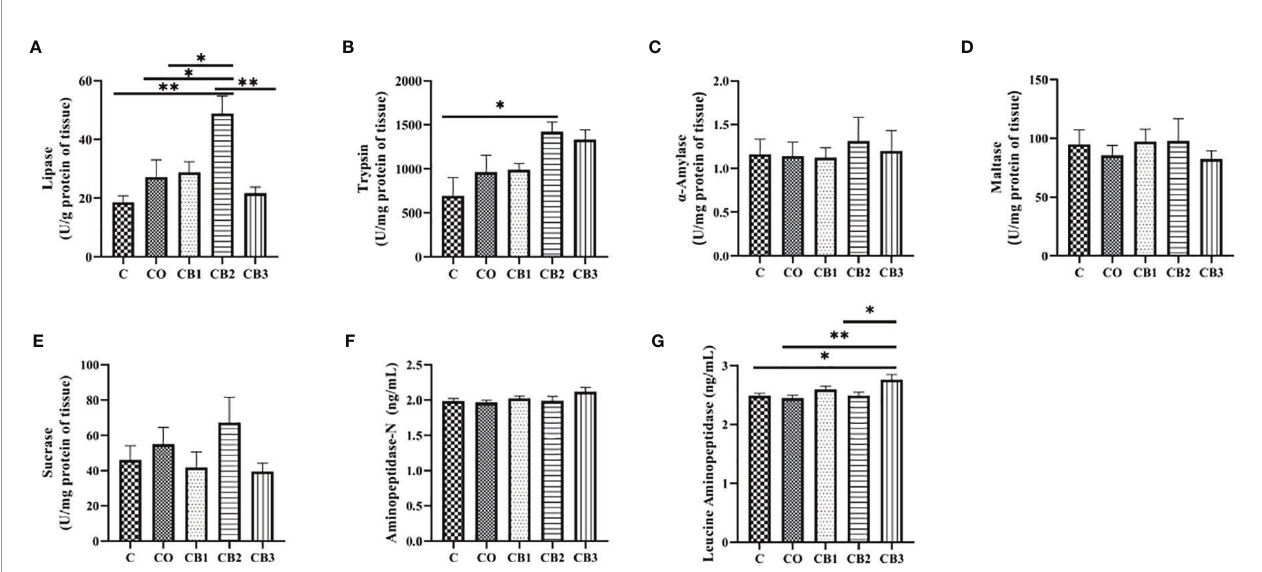
FIGURE 4 | Effects of dietary chitosan oligosaccharides (COS) and Clostridium butyricum synbiotic supplementation on digestive enzyme activity of duodenum content in early-weaned pigeon squabs. (A) Lipase. (B) Trypsin. (C) a -Amylase. (D) Maltase. (E) Sucrase. (F) Aminopeptidase-N. (G) Leucine aminopeptidase. Values are means with the SEM of eight squabs. * p < 0.05 and ** p < 0.01. C group, control group, squabs fed with arti fi cial crop milk; CO group, squabs fed with arti fi cial crop milk + 150 mg/kg COS; CB1, CB2, and CB3 group, squabs fed with arti fi cial crop milk + 150 mg/kg COS + 200, 300, and 400 mg/kg C. butyricum ,